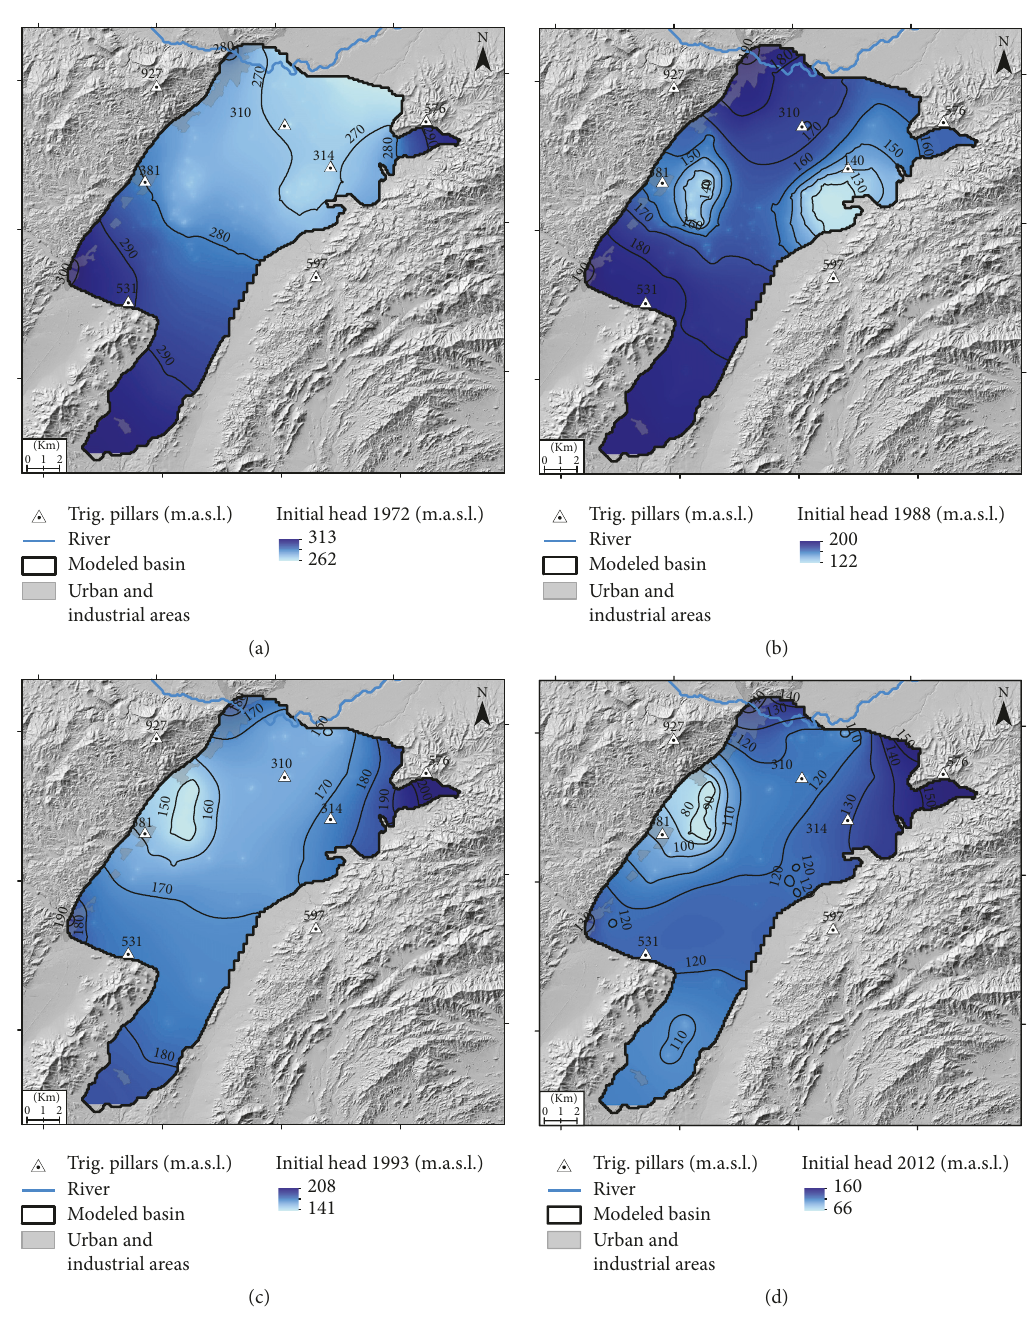
Figure 6: Groundwater model results in different years, 1972 (a), 1988 (b), 1993 (c), and 2012 (d).